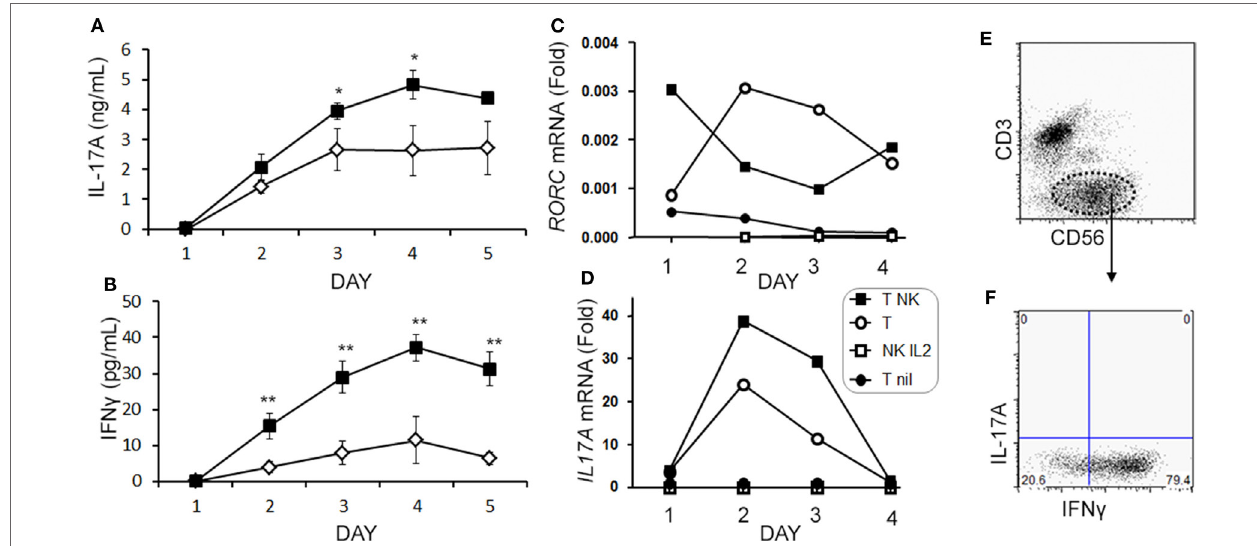
FigUre 8 | Natural killer (NK) cells augment IL-17A and RORC levels in memory CD4 T cells. Purified memory CD4 + T cells from healthy subject PBMCs were activated with anti-CD3, anti-CD28, and Th17 polarizing factors without (open diamond) or with NK cells (closed square). Cytokines IL-17A (a) and IFN- γ (B) were measured in the supernatant by enzyme-linked immunosorbent assay. Expression of RORC (c) and IL17A (D) mRNA was measured by qPCR at the indicated time points. Data are representative of three samples. Groups included non-activated memory CD4 + T cells (T nil; closed circles), activated memory CD4 + T cells (T; open circle), activated memory CD4 + T cells with NK cells (T NK; closed squares), and NK cells cultured alone with IL-2 (NK IL-2; open squares). Representative plots of IL-17A and IFN- γ expression in NK cells (CD3 − CD56 + ) are shown (e,F)